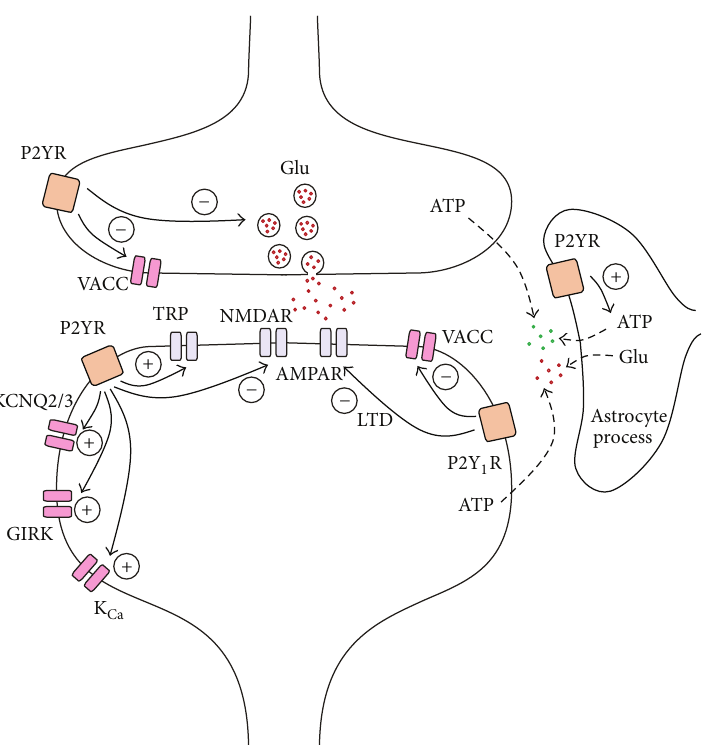
Figure 1: Modulation of excitatory synaptic transmission by P2Y receptors in the CNS. The model synapse shows the main presynaptic and postsynaptic effects of P2Y receptors described in different areas of the brain. For more details see text. AMPAR, AMPA receptor; GIRK, G protein-coupled inwardly rectifying potassium channel; Glu, glutamate; K Ca , calcium-activated potassium channel; LTD, long- term depression; NMDAR, NMDA receptor, P2YR, P2Y receptor; P2Y 1 R, P2Y 1 receptor; TRP, transient receptor potential channel; VACC, voltage-activated calcium